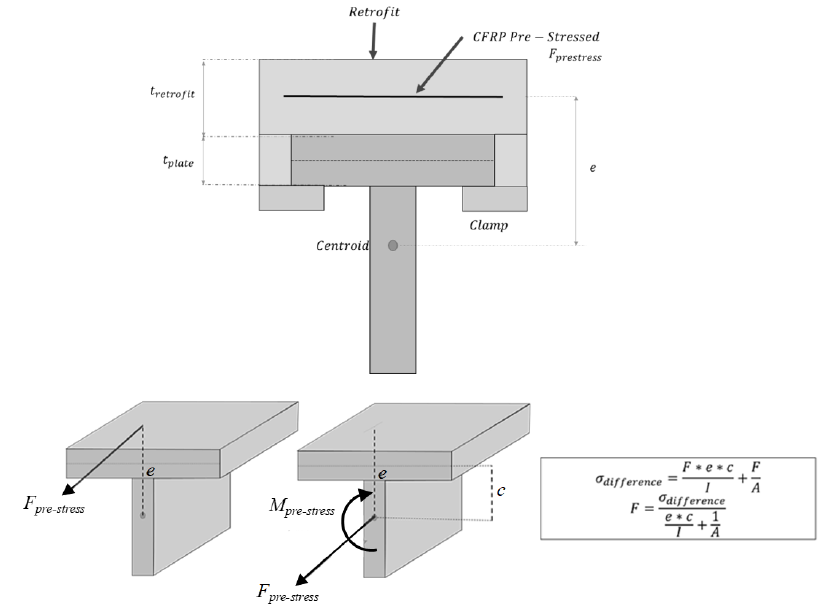
Figure 10. Free body diagram used to calculate the pre-stress force.